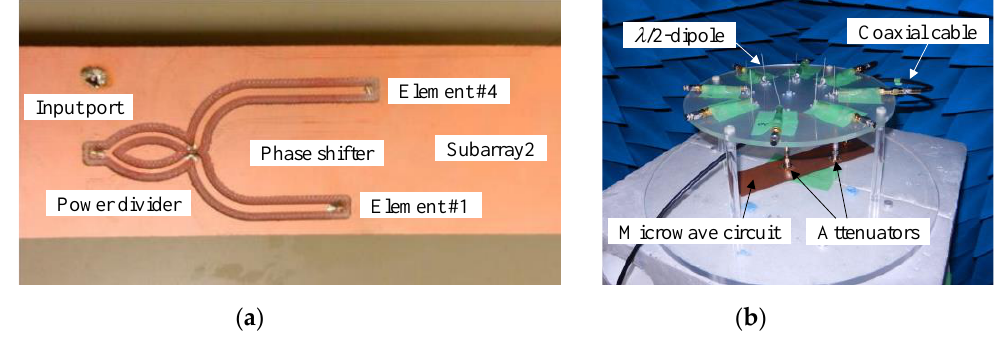
Figure 18. Radiation pattern measurement setup of a 4 × 4 MIMO array in an anechoic chamber. ( a ) Fabricated microwave circuit. ( b ) Prototype of a 4 × 4 MIMO array.